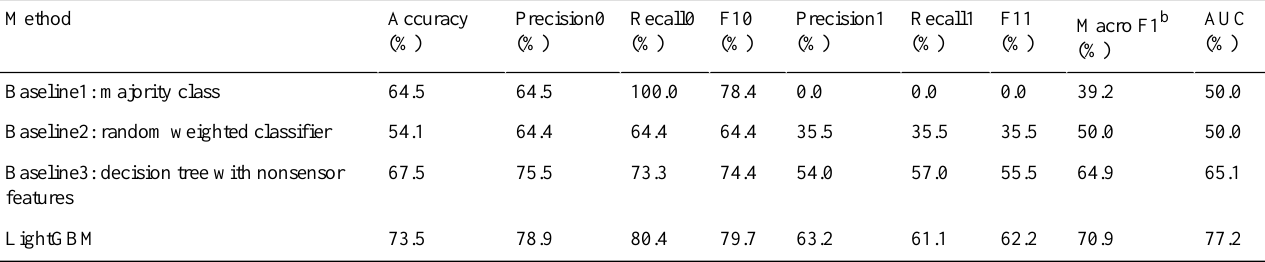
Table 1. Performance of population models classifying next-day symptom class.